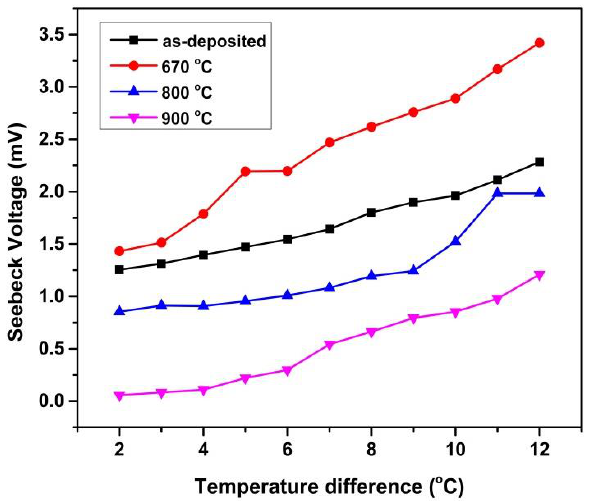
Figure 7. Graph displaying Seebeck voltage and temperature difference of as-deposited and annealed p-type SiGe thin films.